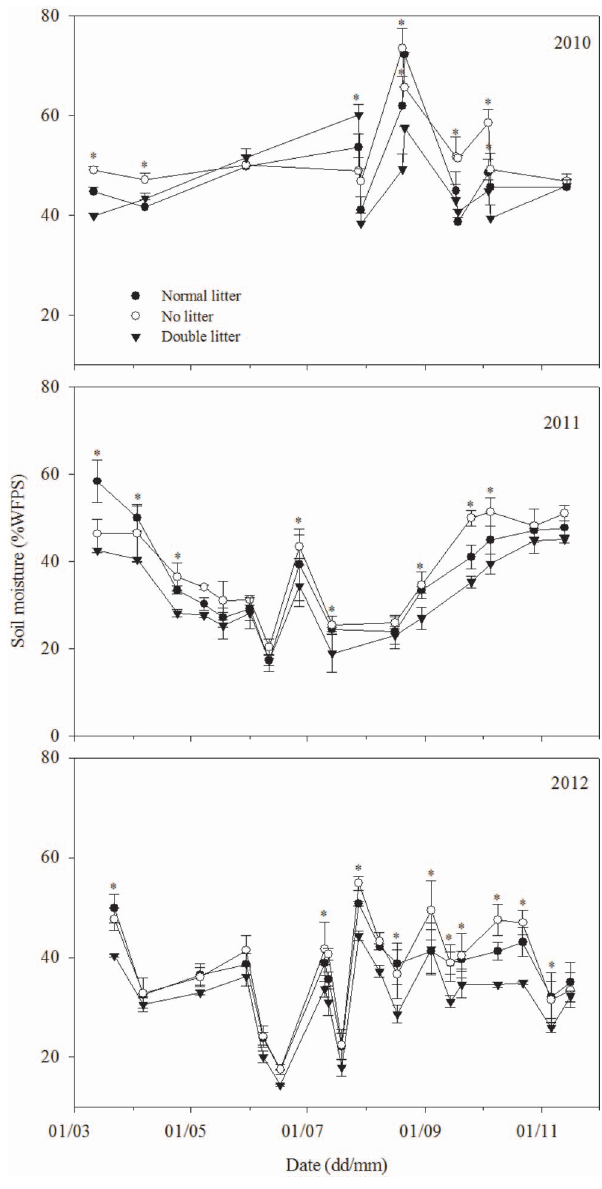
Figure 3. Variation in soil moisture (% WFPS) at a depth of 0 2 5 cm for different litter treatments, including normal litter, no litter, and double litter treatments in 2010, 2011, and 2012, respectively. The asterisk indicates a significant difference at P ,